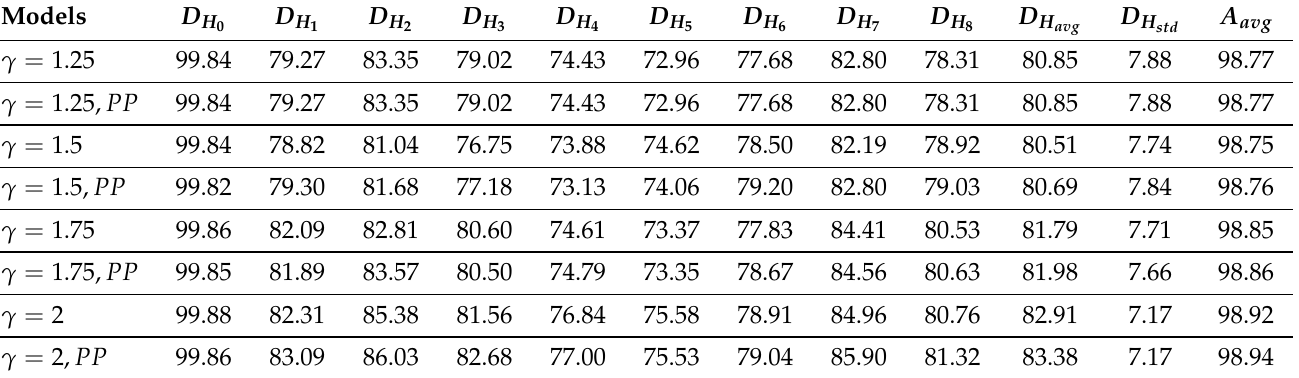
Figure 5. ( a ) Prediction obtained from the 2.5D V-Net trained with our formulation of the focal Dice loss. For these images, the model was trained with FDL A with γ = 2. ( b ) Corresponding ground-truth. Table 3. Results for the models trained with the FDL A formulation, as defined in Equation (11). Comparisons for the different liver segments. PP stands for Post-Processing. D H is the “hard” Dice t coefficient for class t . It is reported as a percentage. D H is the arithmetic mean of D H . D H is the avg t std standard deviation of D H . The average accuracy is denoted as A avg t